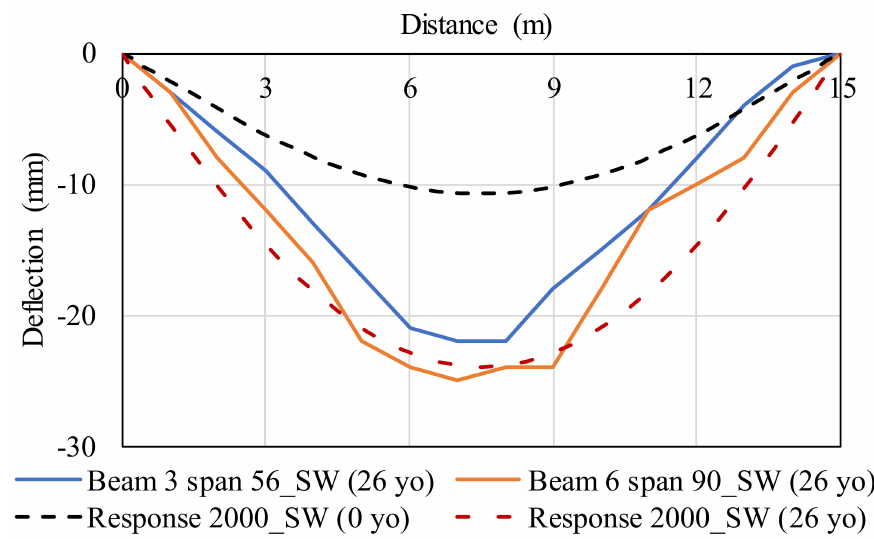
Figure 6. The deflection of the beam obtained from both field measurement and Response 2000.